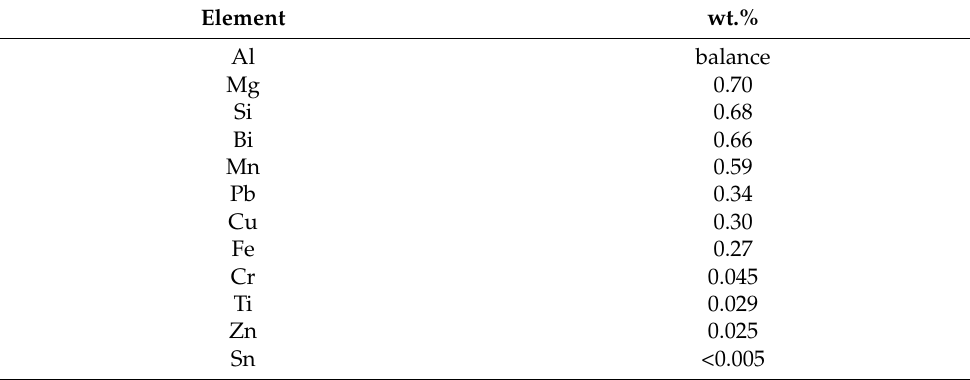
Table 1. Composition of investigated aluminum alloy AW EN 6026.